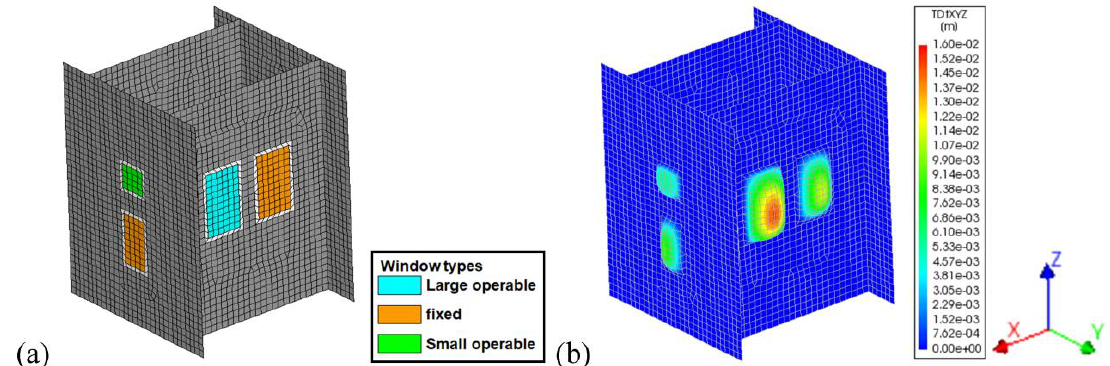
Figure 7. Hydrostatic analysis of the specimen: ( a ) numerical model and ( b ) deformation distribution contours at the 3-m water depth.